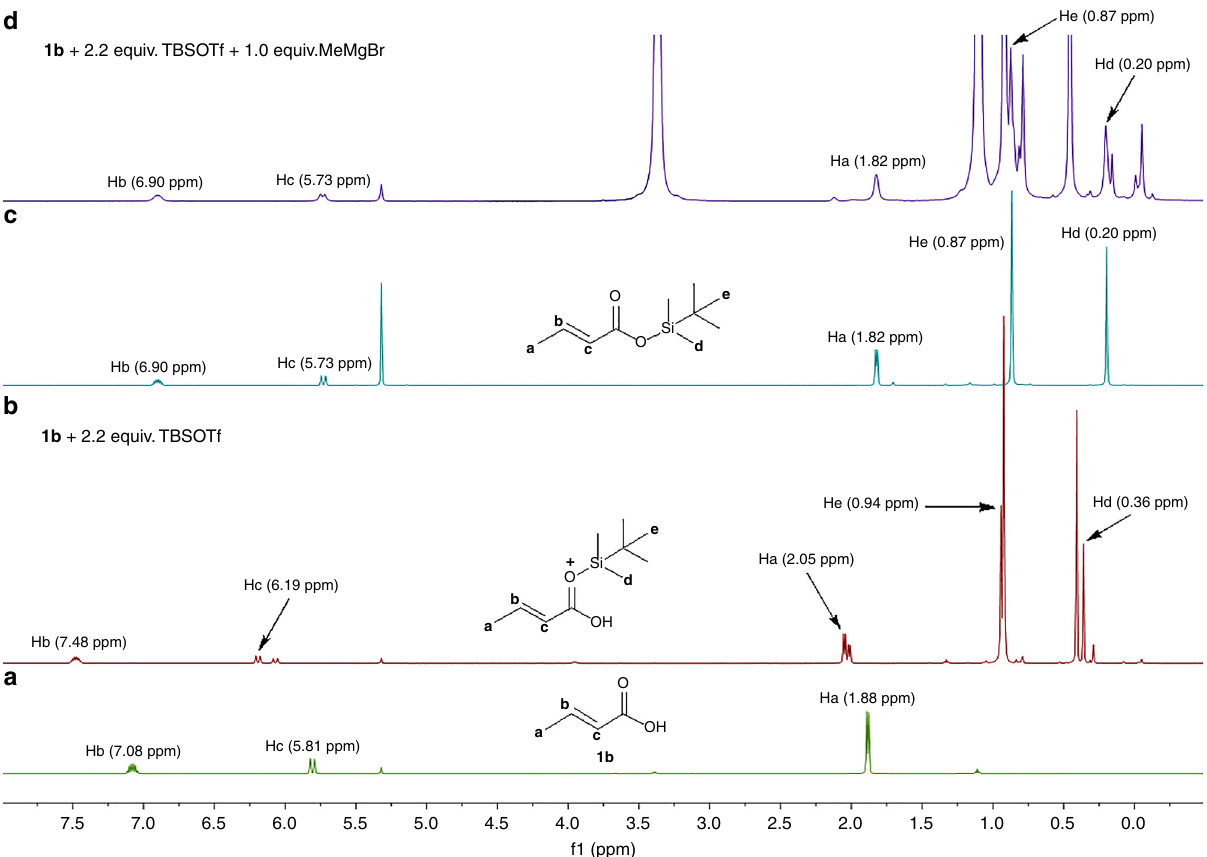
Fig. 3 1 H NMR experiments carried out in CD 2 Cl 2 at − 55 °C using substrate 1b , t BuMe 2 SiOTf and MeMgBr. a Crotonic acid 1b . b Mixture of 1b with 2.2 equiv. of t BuMe 2 SiOTf. c Isolated pure t BuMe 2 Si-ester of 1b . d Mixture of 1b with 2.2 equiv. of t BuMe 2 SiOTf followed by addition of 1.0 equiv. of